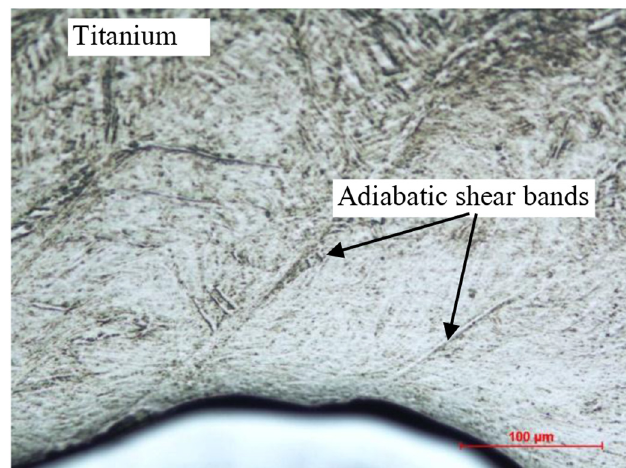
Fig. 5. Microstructure of titanium near the bond in specimen after the